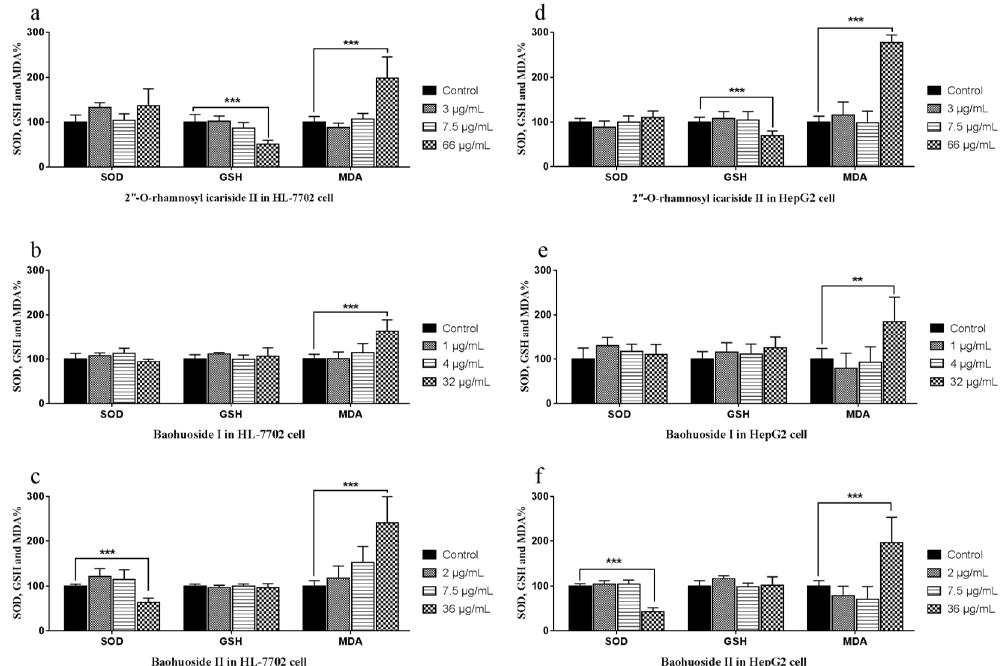
Figure 3. Effects of 2 ″ - O -rhamnosyl icariside II, baohuoside I and baohuoside II on the SOD, GSH